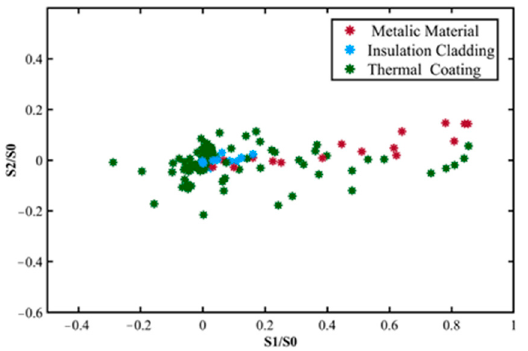
Figure 12. Spatial distribution of normalized Stokes vectors of space debris.